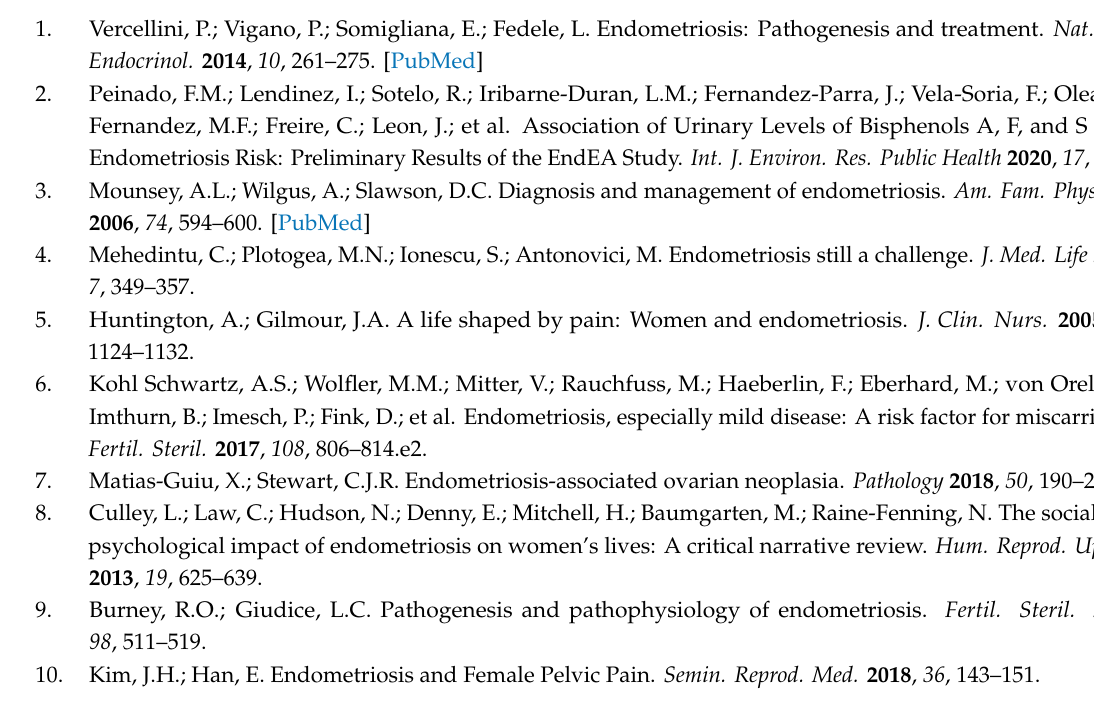
Table S1: Health-related fitness in healthy women and a ff ected women with low fatigued and fatigued, Table S2: Perceived physical fitness, sleep quality and quality of life in healthy women and a ff ected women with low fatigued and